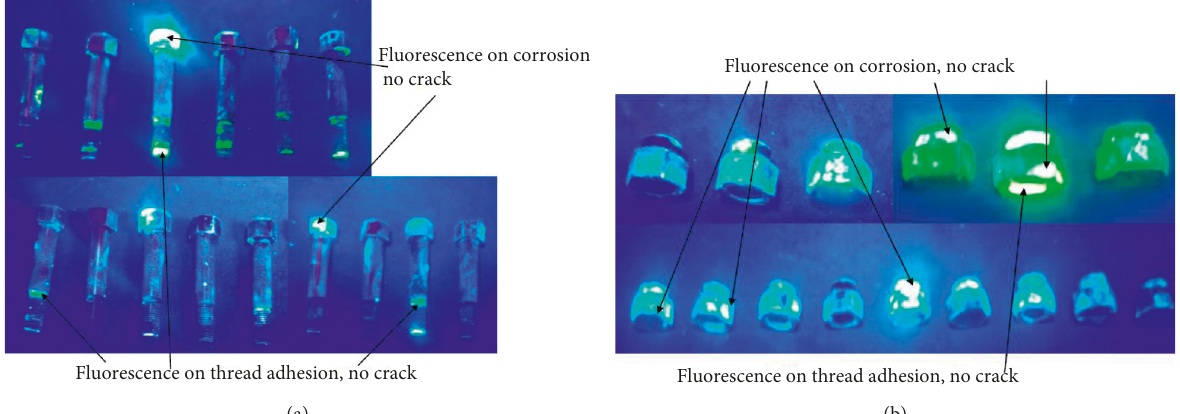
Figure 9: Fluorescence inspection results of test pieces. (a) The photo of bolt flaw detection. (b) The photo of nut flaw